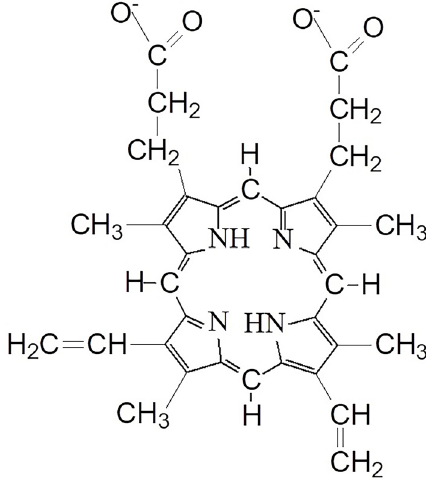
Figure 1. Chemical structure of synthetic protoporphyrin